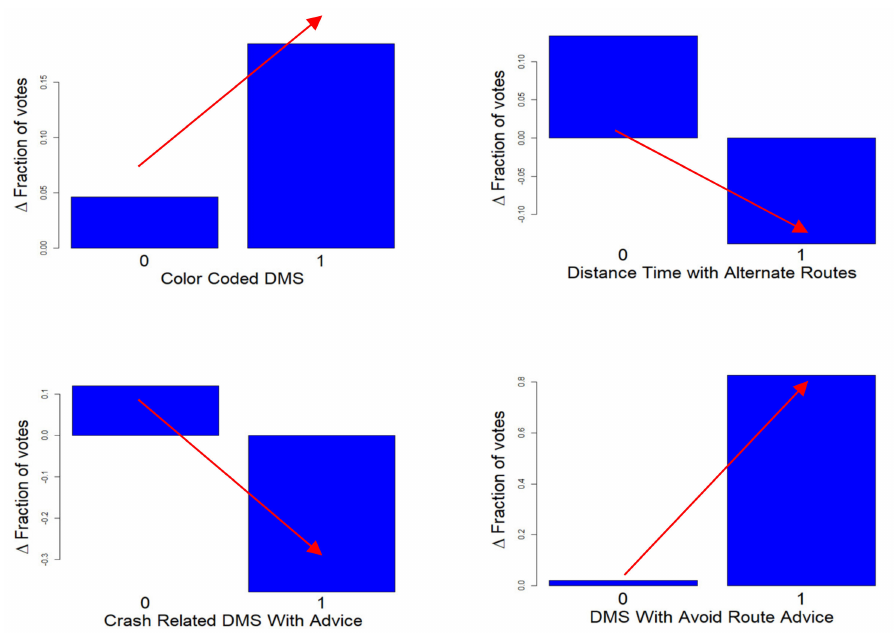
Figure 12. PDPs of important variables impacting compliance behavior (the direction of the trend is shown by the red